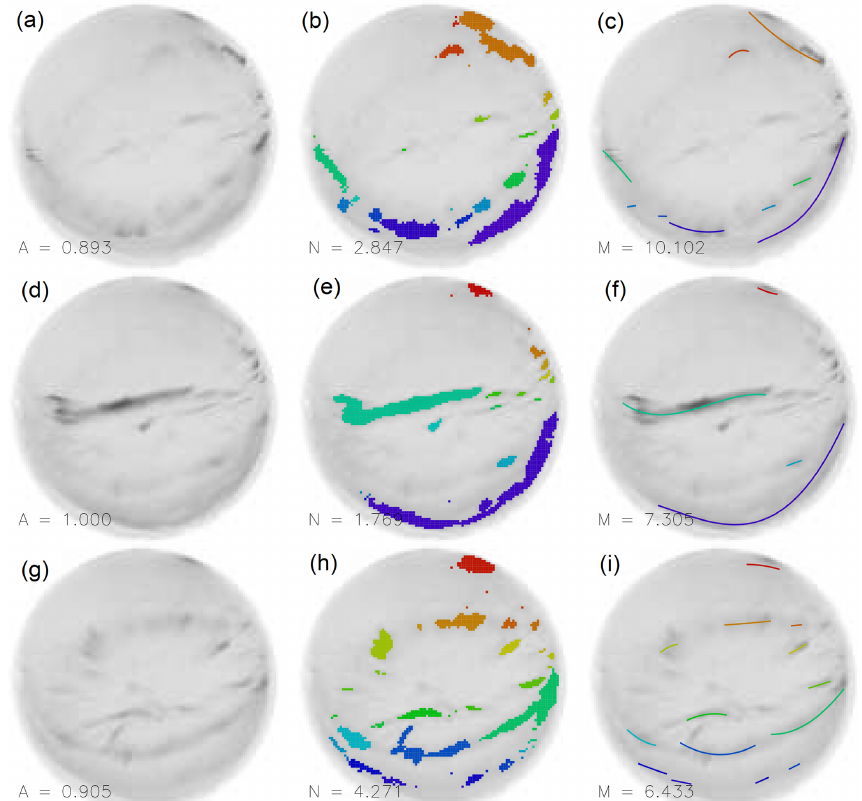
Figure 4. ASC images (a) , (h) , and (m) from Fig. 2 in an inverted gray scale with the associated arciness value A (a, d, g) , weighted number of bright pixel clusters N overlaid on original images using arbitrary color coding to distinguish between different clusters (b, e, h) , fit polynomials drawn onto original image for each cluster along with the M value of each image (c, f, i)